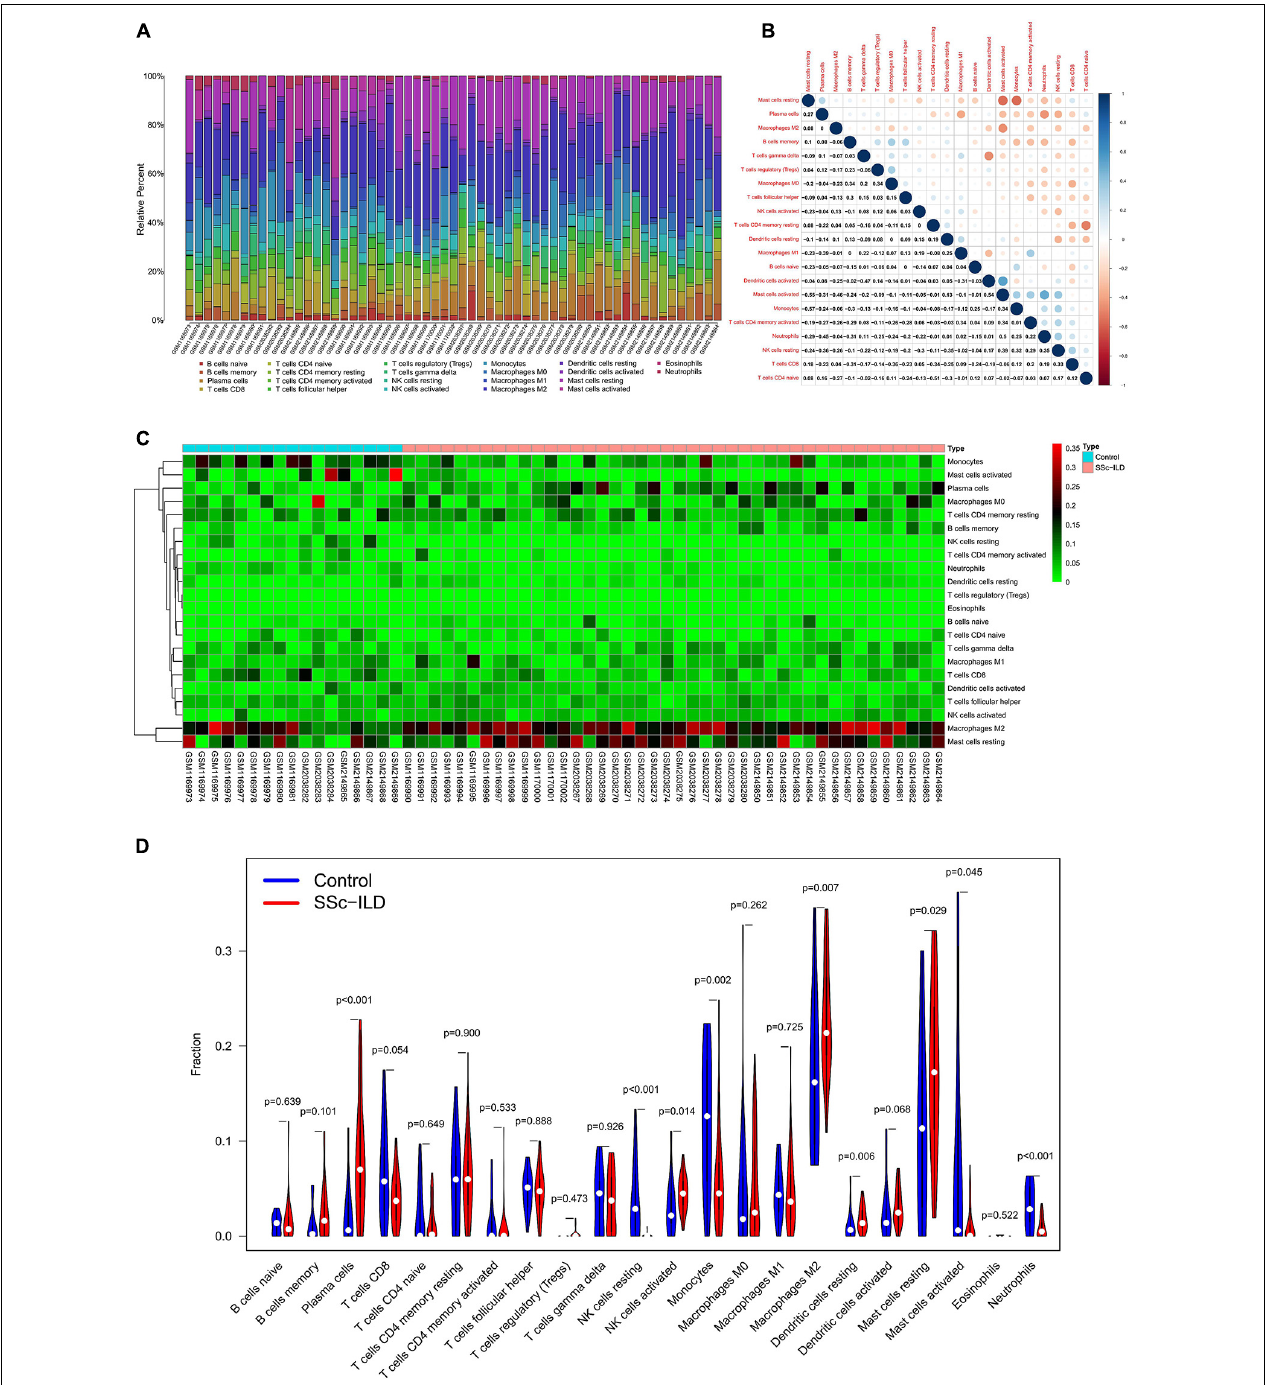
FIGURE 6 | Composition of infiltrating immune cells in lung tissues. (A) The distribution of immune cell types in each sample. (B) The correlation among immune cell types. (C) The heat map of infiltrating immune cells. (D) The violin plot of infiltrating immune cells.